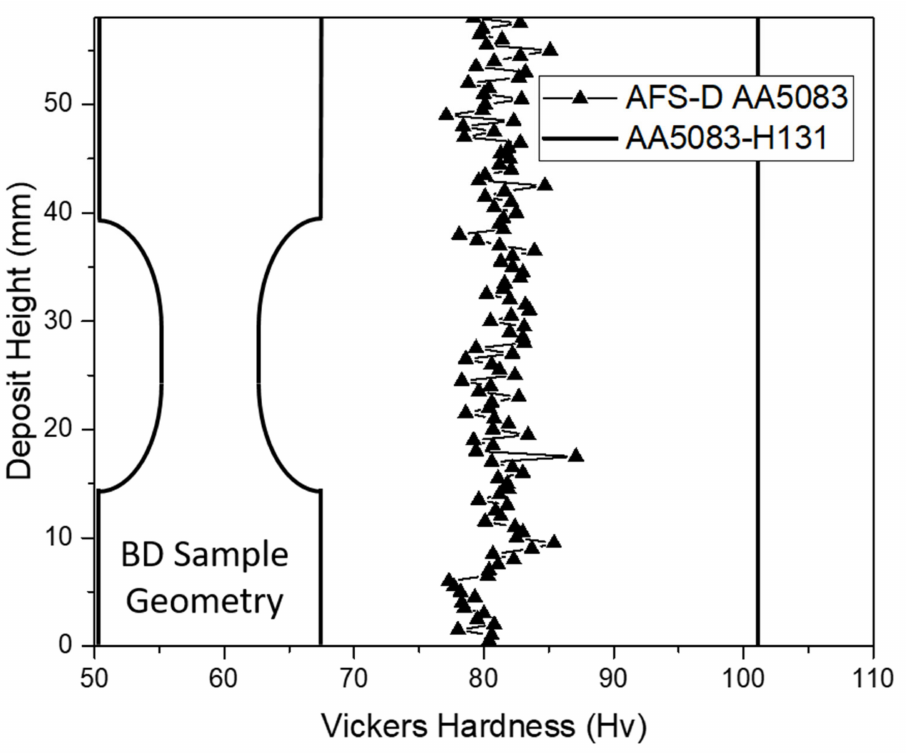
Figure 6. Vicker’s hardness plot with respect to the sample geometry for both AA5083-H131 control and AA5083 processed with AFS-D.